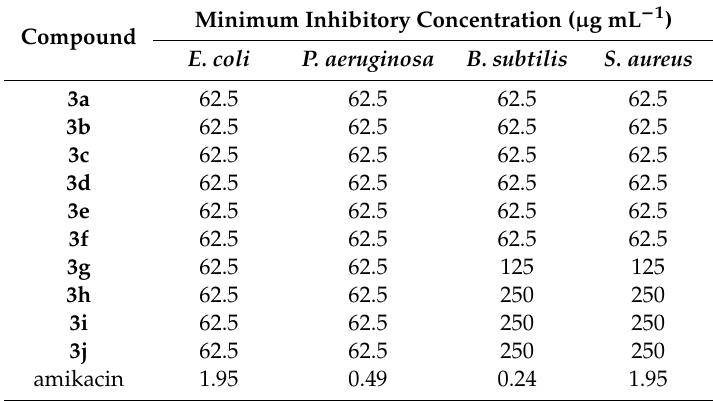
Table 1. Antibacterial activity of synthesized compounds in terms of minimum inhibitory concentration (MIC) against Escherichia coli, Pseudomonas aeruginosa, Bacillus subtilis and Staphylococcus aureus ( μg mL − 1 ).